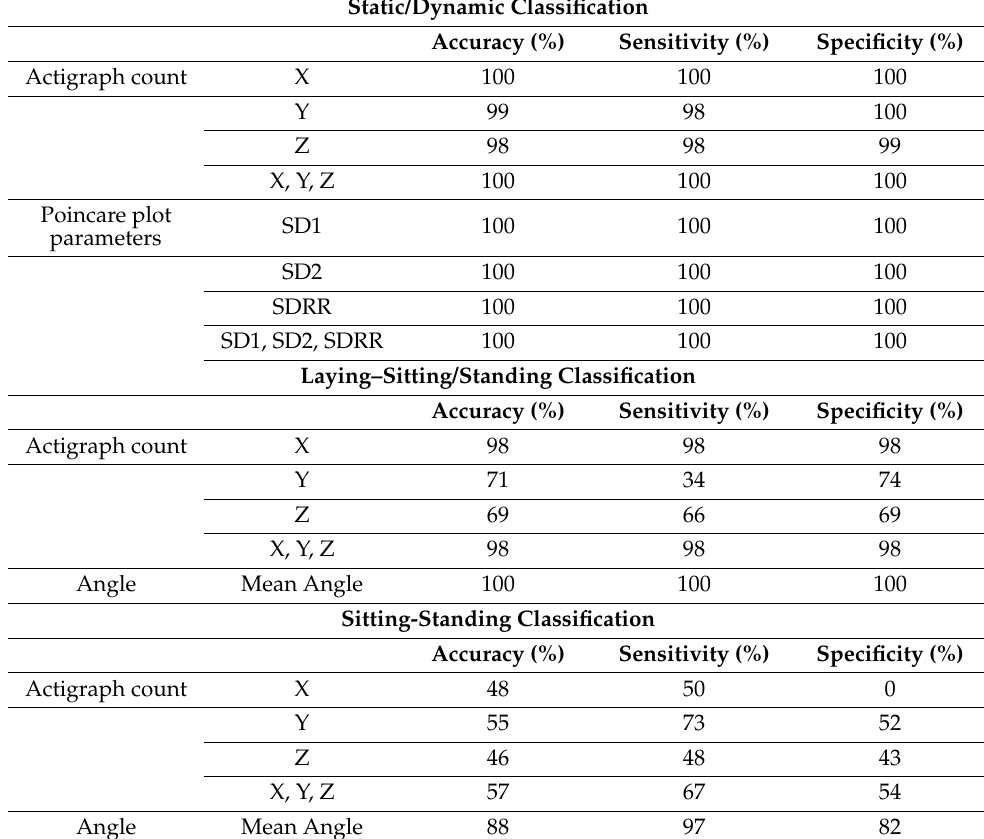
Figure 9. ROC curve for static and dynamic classification. The left panel denotes the ROC curve for the Actigraph count- based static and dynamic activities’ classification. The right panel denotes the Poincare plot-based static and dynamic activities’ classification.